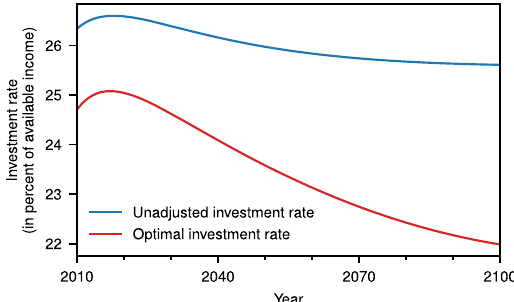
Fig. 3 Comparison of the unadjusted and optimal investment rate. The optimal investment rate is signi fi cantly lower than the unadjusted version. Note that the unadjusted investment rate is the same for a scenario with climate change and one without. Source data are provided as a Source Data fi